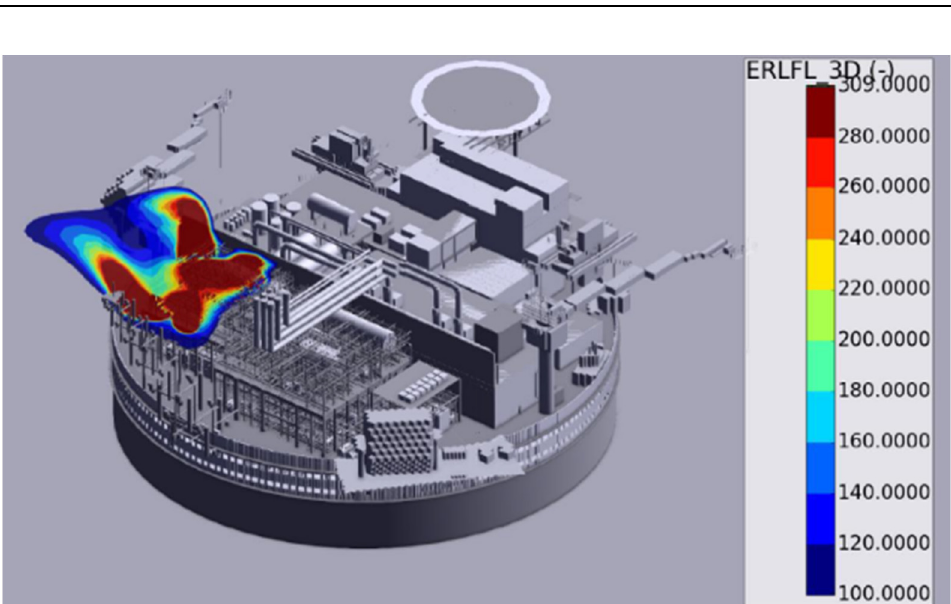
Figure 10. Largest gas cloud (case 661,124) obtained for the simulated cases. Downward leakage, 50 kg/s leak rate, east wind direction, and 6 m/s wind speed.